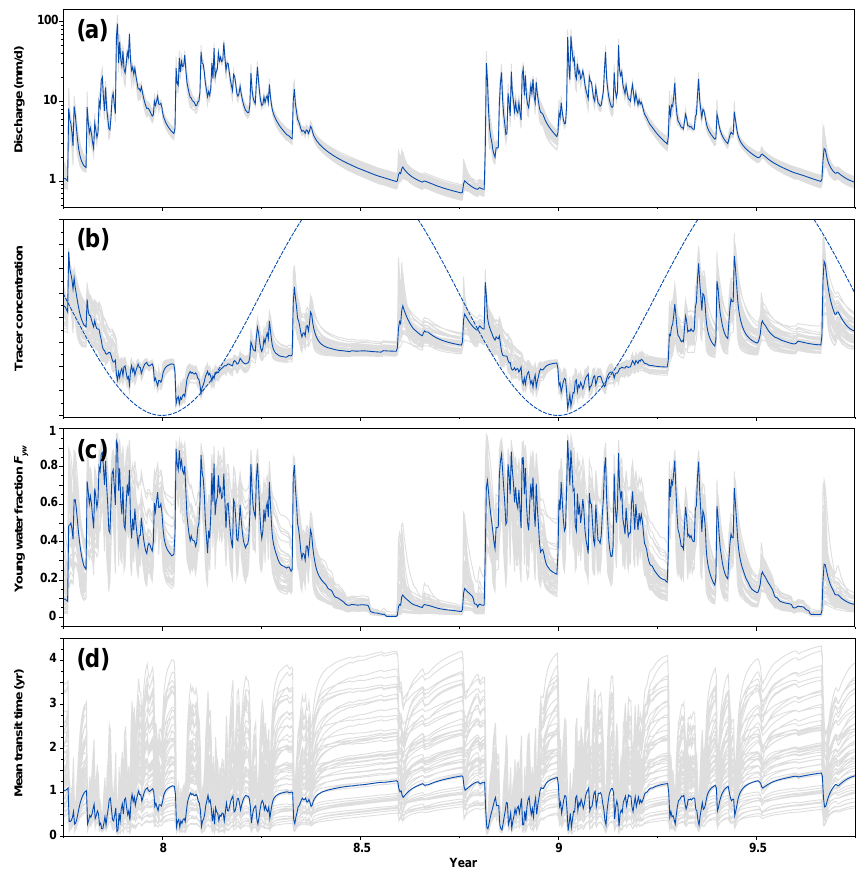
Figure B3. Excerpts from time series of discharge, tracer concentrations, young water fractions, and mean travel times in the two-box model with Smith River (Mediterranean climate) precipitation forcing and the reference parameter set (the dark lines, for the parameter values shown by the red squares in Figs. B1 and B2) and the 50 parameter sets that come closest to matching the reference discharge time series (the light gray lines, for the parameter sets shown by the solid blue dots in Figs. B1 and B2). The 50 gray hydrographs (a) cluster closely around the blue hydrograph (which is unsurprising because they have been selected to do so). The 50 gray tracer concentration curves (b) also generally follow the blue curve (the precipitation tracer sinusoid is shown for comparison by the dashed line). By contrast, the young water fraction F yw (c) and mean transit time (d) are much more variable; the gray curves vary by an average range of 0.3 in F yw and a factor of 9.5 in mean transit